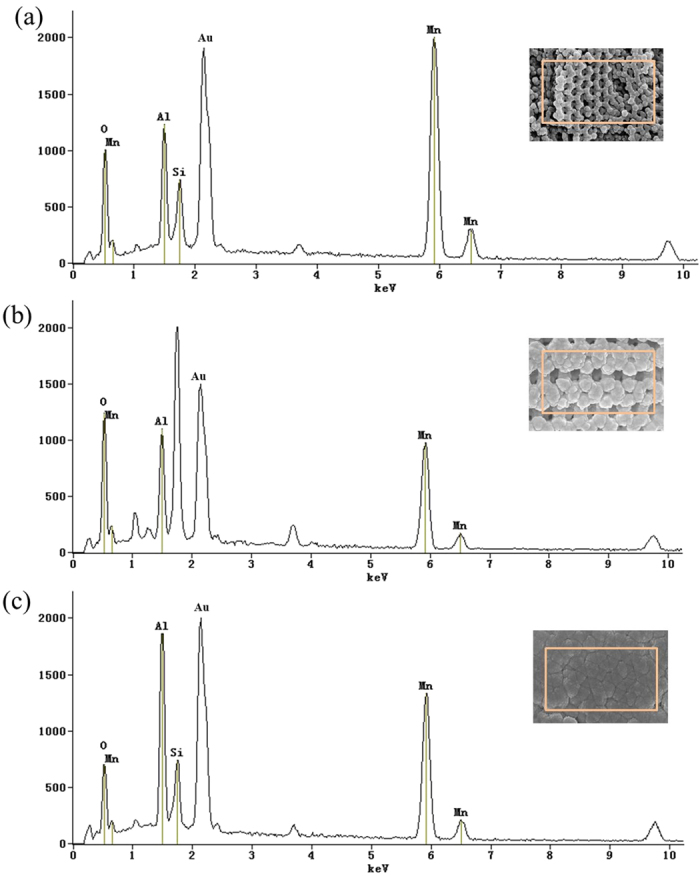
EDS spectrums of the Mn2O3/Al membrane with different aluminizing time.(a) 10 min, (b) 20 min, (c) 30 min.